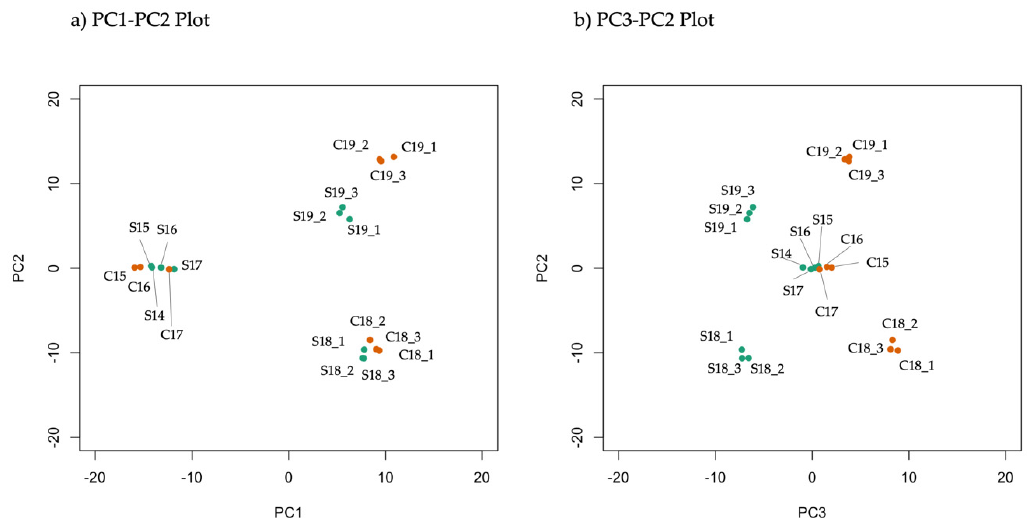
Figure 2. Principal component analysis (PCA) plot based on the intensity of the compounds in coarse green tea samples. ( a ) PCA plot of PC1-PC2. ( b ) PCA plot of PC2-PC3. S14, S15, S16, S17, S18, S19, C15, C16, C17, C18, and C19 correspond to the samples Syneco 2014, Syneco 2015, Syneco 2016, Syneco 2017, Syneco 2018, Syneco 2019, Conv 2015, Conv 2016, Conv 2017, Conv 2018, and Conv 2019, respectively. The 2014–2017 samples are based on a single measurement, while the 2018 and 2019 samples consist of 3 different measurements of intensity data.